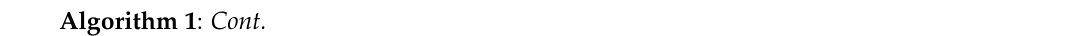
8 of 19 Figure 2. Coordination node synchronization process. Let us assume that each sensor node communicates at the distance of the single-hop node to detect the hidden nodes. Each sensor node sends the HELLO message ‘Hm’ at the distance ‘d’ within the subdivision ‘Sd’ and is located at the N × N area of WMSN. The residual energy of the two types of multimedia sensor nodes, the coordinator node ’C’ and the non-coordinator node ‘Cn’, can be determined as follows. The coordinator node performs four types of jobs that include the synchronization with newly joined nodes, broadcasting the information of newly joined nodes inside the subdivision, scheduling the transmission of subdivision, and data collection from non-coordinator nodes of the subdivision. The synchronization process between the newly joined node and the coordinator is explained in Algorithm 1. Algorithm 1 : Priority-based synchronization process between coordinator and newly joined nodes 1.